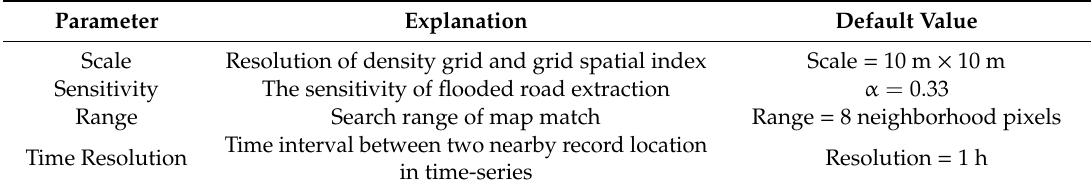
Table 1. Default parameters for extracting flooded